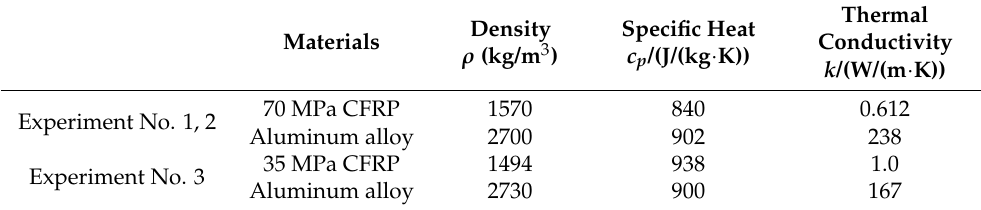
Table 2. Thermal physical properties of solid materials